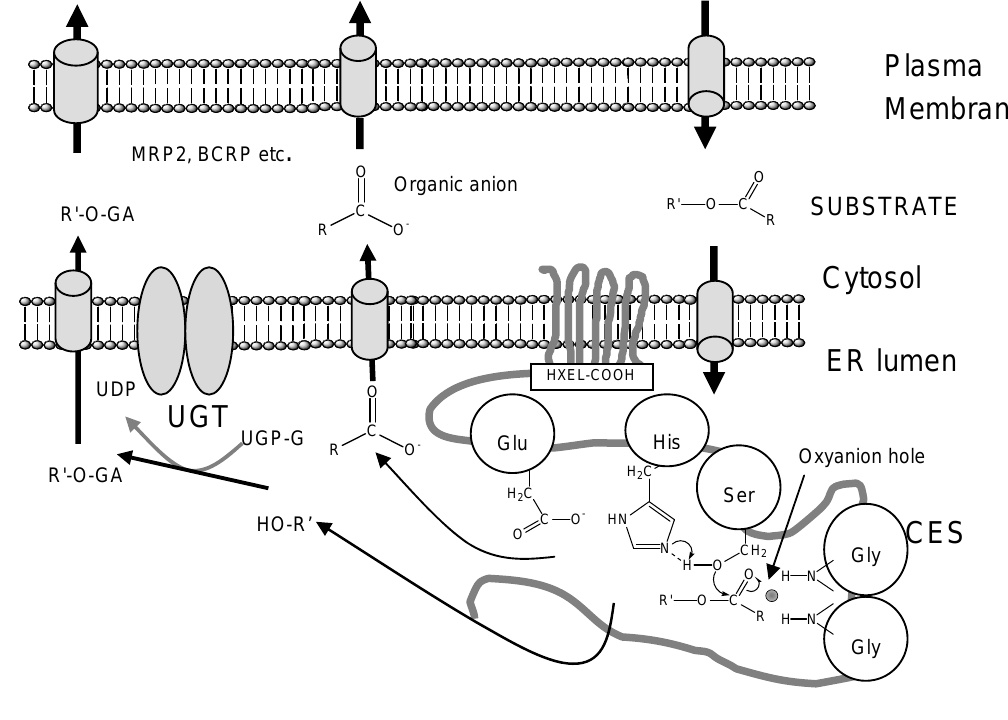
Figure 1 . CES-UGT interaction in the luminal side of the ER membrane and CES- transporter interaction in the